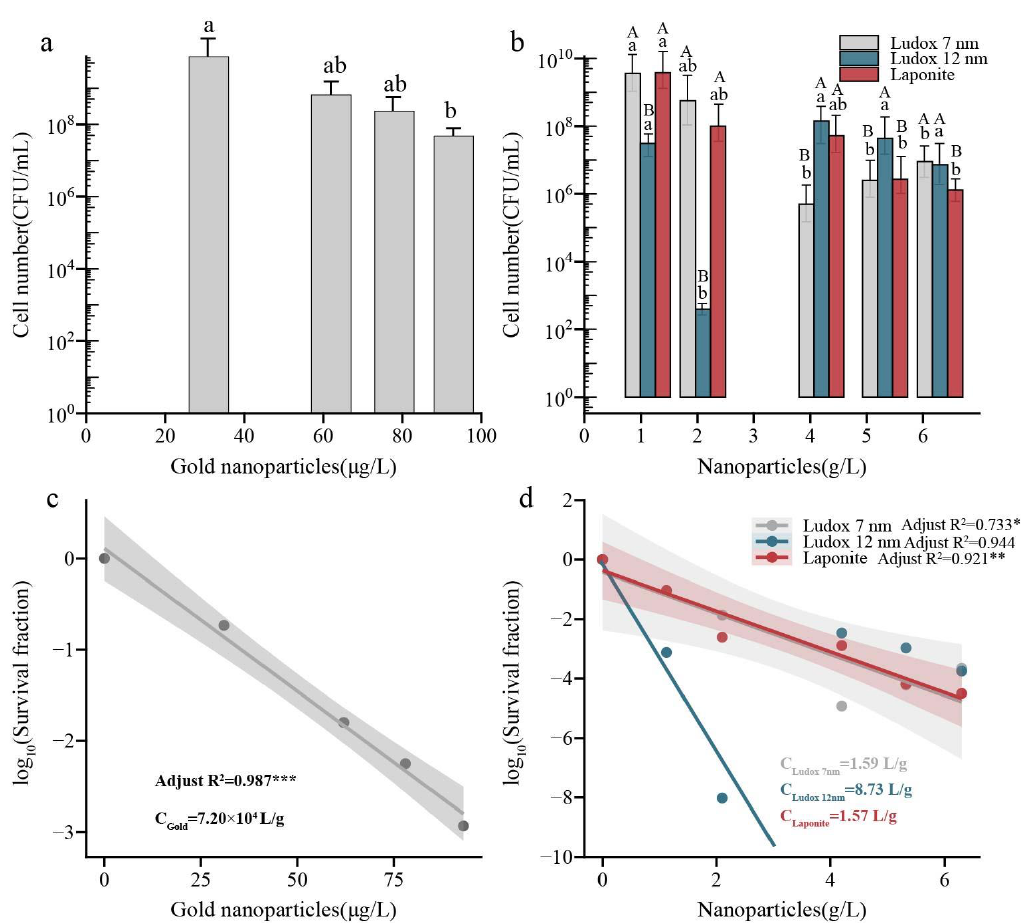
Figure 1. Number of E. coli colonies from LB agar medium containing nanoparticles at different concentrations. The initial cell concentration (CFU/mL) was 10 10 . ( a ) Gold nanoparticle; ( b ) ludox 7 nm, ludox 12 nm, and laponite; ( c ) effect of gold nanoparticles on the bacterial susceptibility constant; ( d ) effect of ludox 7 nm, ludox 12 nm, and laponite nanoparticles on the bacterial susceptibility constant. Differences in cell concentration (CFU/mL) among nanoparticles at different concentrations were obtained by one-way ANOVA ( p < 0.05) followed by Turkey’s multiple comparison tests. Lowercase letters represent the difference in the number of bacteria at different concentrations of the same type of nanoparticles, and uppercase letters represent the difference in the number of bacteria at the same concentration of different types of nanoparticles. *, 0.01< p <0.05; **, 0.001< p <0.01; ***, p <0.001.